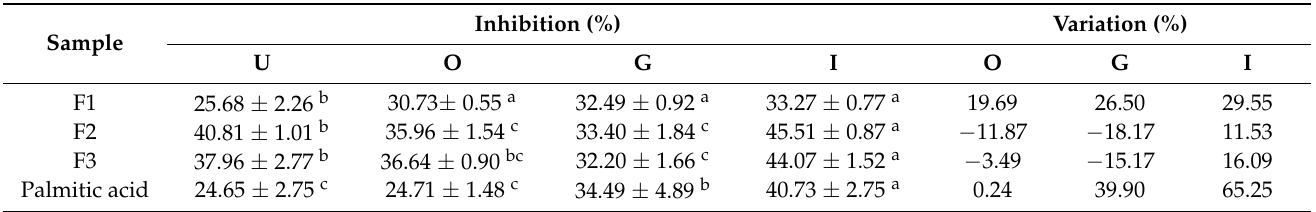
Table 2. Effect of in vitro digestion on cytotoxic activity against U266 cell line of palmitic acid, F1, F2, and F3 fractionated from Sargassum spp. at a concentration of 0.2